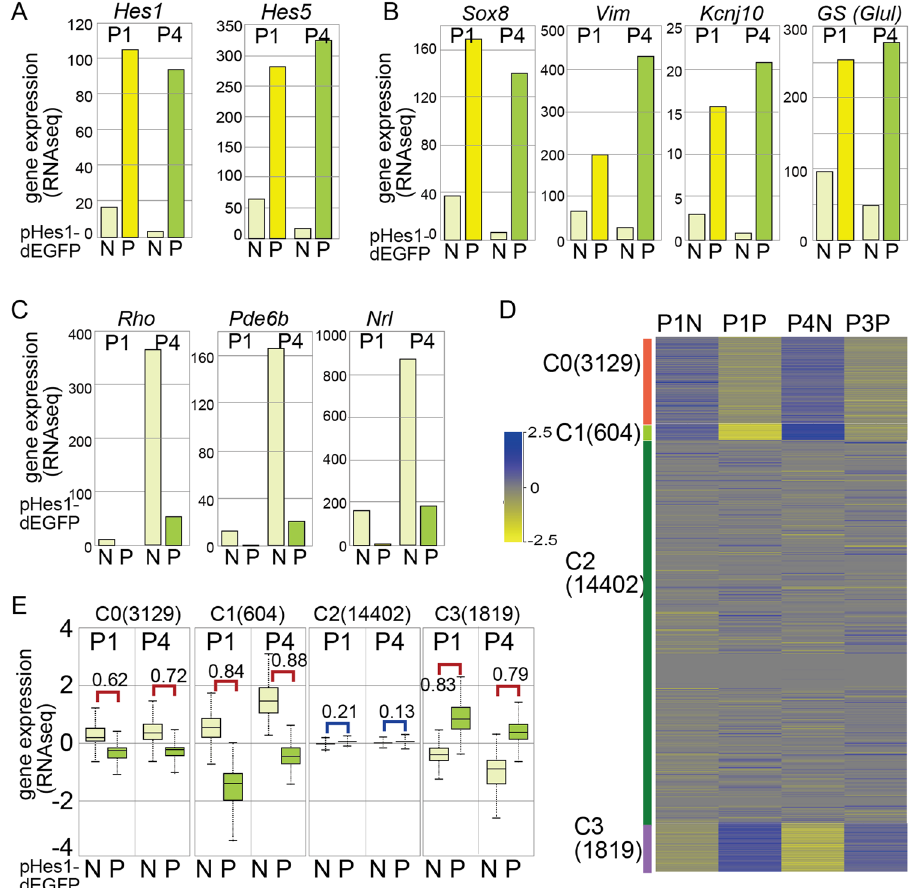
Figure 1. Fractionation of retinal cells by EGFP expression from pHes1-EGFP transgenic mouse retina. ( A , B , C ) RNA-seq using purified EGFP positive (P) and negative (N) cells of retina from pHes1 -EGFP mouse at P1 and P4 was done. RNA-seq values of genes related to Müller glia ( A , B ) or photoreceptor ( C ) are shown. ( D , E ) Unsupervised K-means clustering of all genes on the RNA-seq to generate 4 clusters was done ( D ), and the distribution of gene expression of the clusters 0, 1, 2, and 3 in pHes1-EGFP positive (P) and negative (N) populations are shown ( E ). Numbers in parentheses are gene number in each cluster. Statistical analysis was done by student’s t test, and effect size of the results was examined by Pearson’s correlation coefficient (r) and indicated in the figure. N, negative; P,